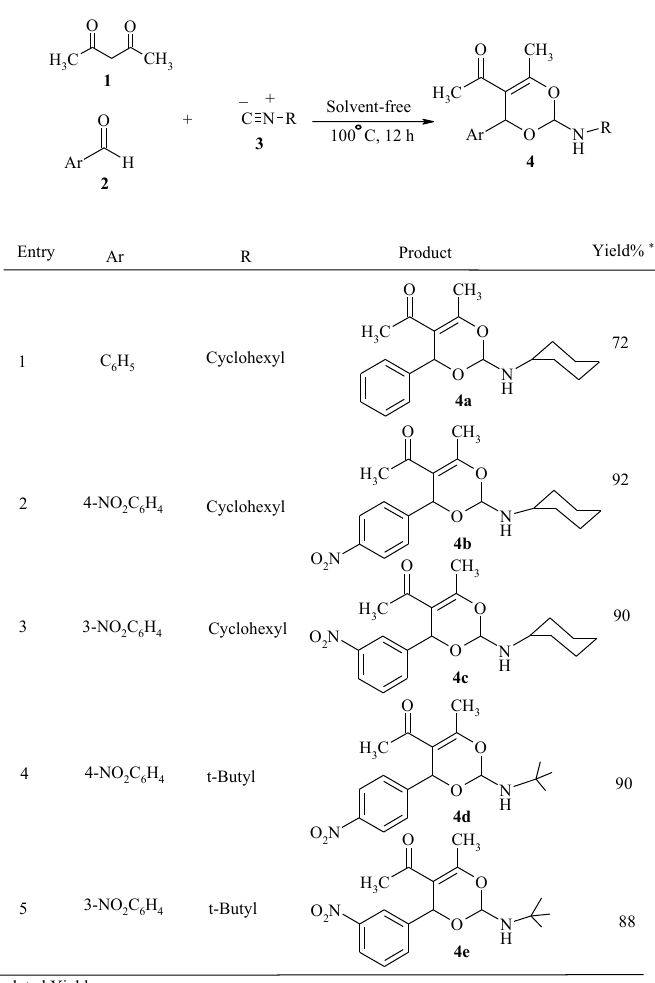
Figure 2. Three-component reaction of alkyl isocyanides, aryl aldehydes, and acetylacetone in solvent-free